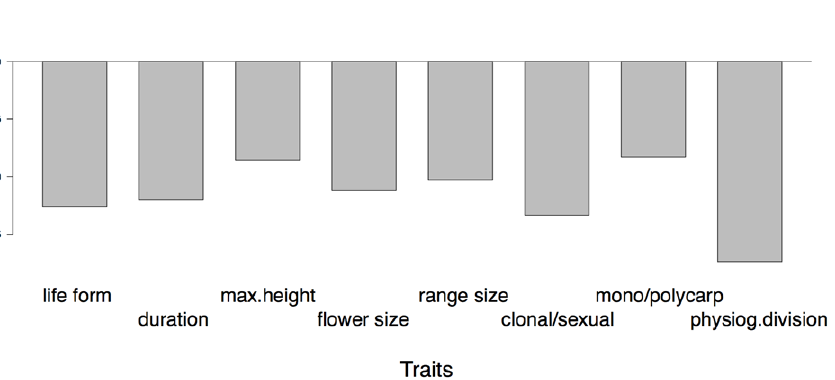
Figure 1. Traits variable importance values. Variable importance for the distributional and biological traits from the random forest analysis examining whether listed plant species can be grouped by traits only (n=213). Variable importance is measured as the mean decrease in model classification accuracy when values for that variable are randomly permuted. Abbreviations: duration=life history duration, max.ht.=maximum plant height, max.flower=maximum flower size, range, reprod.mode=reproductive mode, reprod.repetition=reproductive repetition, physiogdiv=phy-